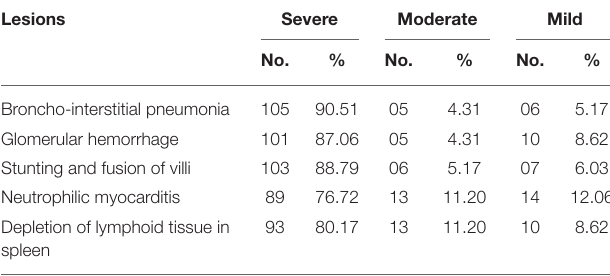
TABLE 5 | Intensity and frequency of microscopic lesions in goats ( n = 116) died of